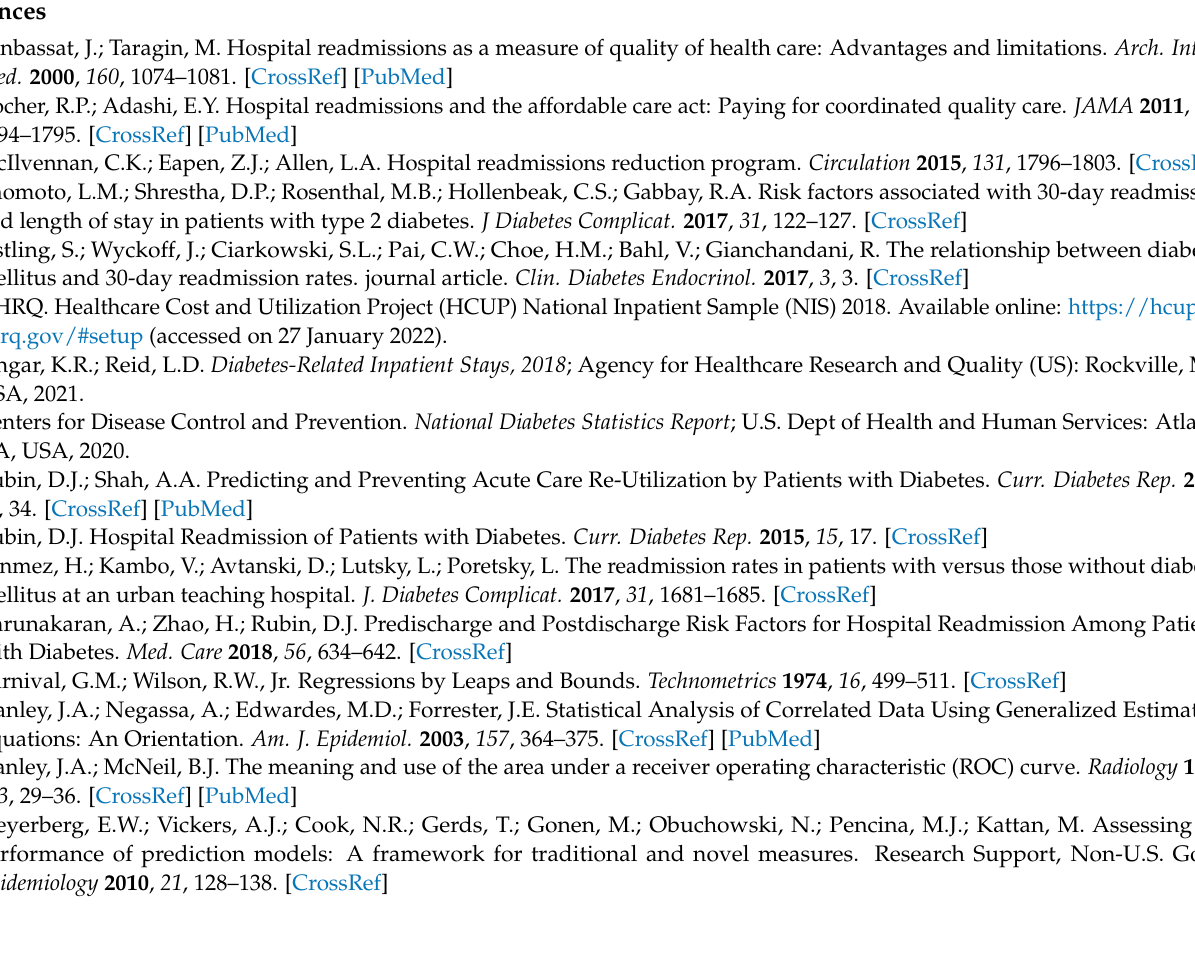
Table S4. Risk factors for readmission in subgroup of patients with a secondary discharge diagnosis of diabetes and an HbA1c value (n = 1492), OR (95%